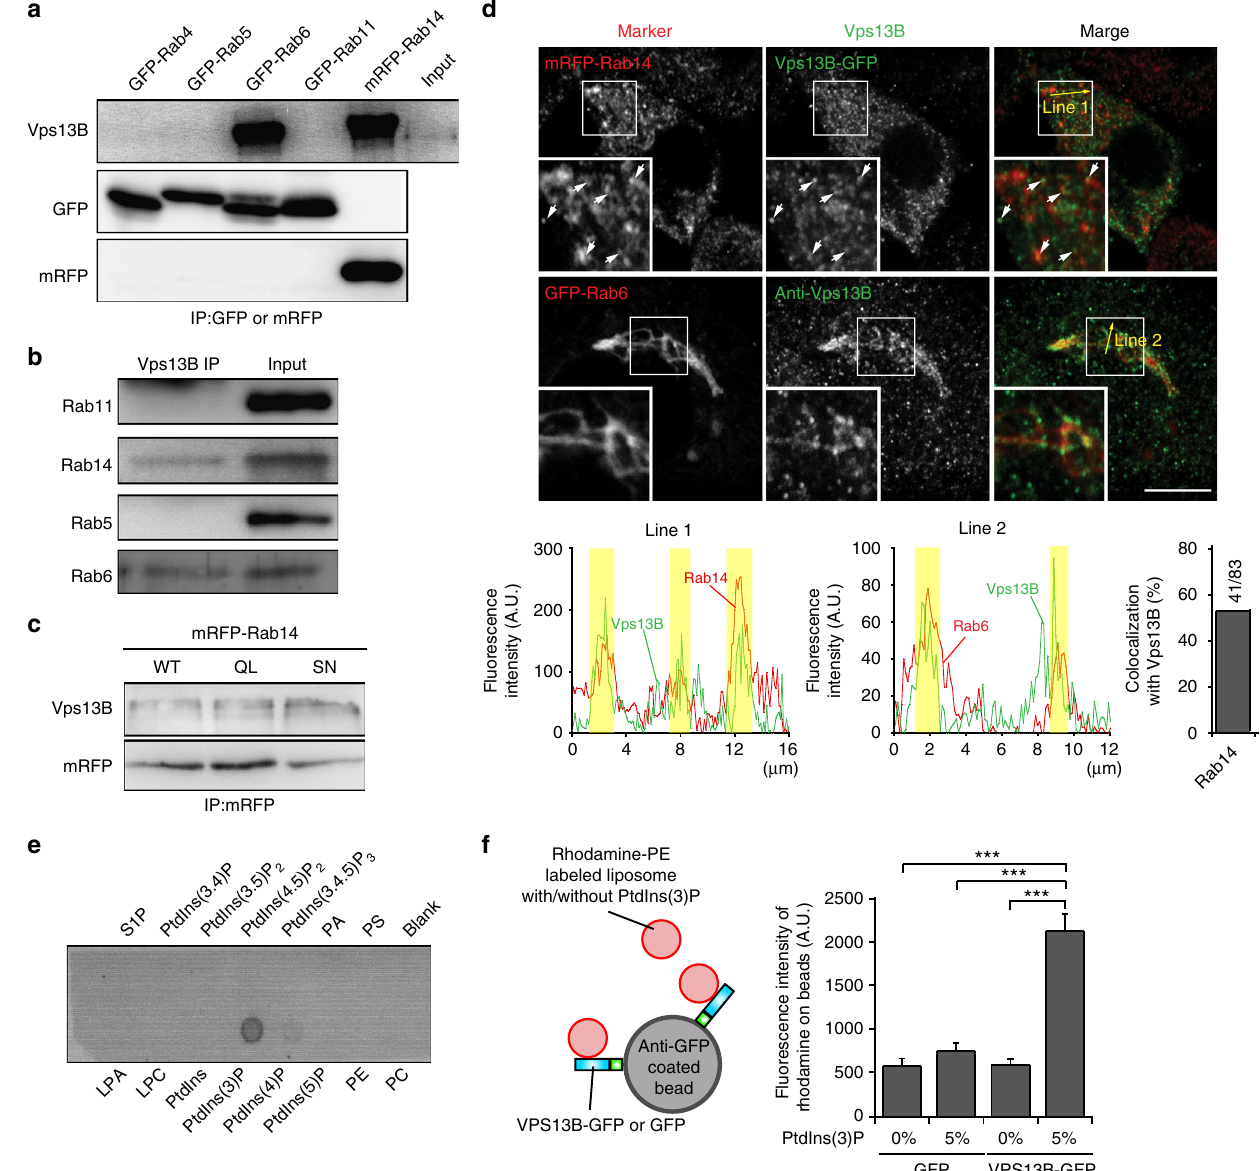
Fig. 6 Vps13B speci fi cally binds to Rab14 and Rab6 and to PtdIns(3)P. a , b Association of endosomal Rab proteins with Vps13B, revealed by co- immunoprecipitation of endogenous Vps13B with GFP (or mRFP)-tagged Rab proteins. a GFP (or mRFP)-tagged proteins were precipitated from cell lysates using a GFP-trap or anti-mRFP antibody. Bound proteins were analyzed by immunoblotting for Vps13B, GFP, and mRFP. b Cross-linked cells were lysed and immunoprecipitated with anti-Vps13B antibody. The interaction of Rab proteins was detected and indicated Rab protein antibodies. c Coimmunoprecipitation of VPS13B with mRFP-Rab14-WT, GTP-locked mRFP-Rab14Q70L (QL), or GDP-locked mRFP-Rab14S25N (SN) expressed in HeLa cells. Anti-RFP antibody was used for immunoprecipitation of mRFP-tagged Rab14 proteins. There was no signi fi cant difference in the binding of Vps13B to the Rab14 variants. d Vps13B co-localizes with Rab6 and Rab14 upon expression in HeLa cells. Top panel: cells were transfected with mRFP-Rab14 and Vps13B-GFP and analyzed for the presence of GFP and mRFP, respectively, by fl uorescence microscopy. Bottom panel: cells were transfected with GFP-Rab6. In this case, the distribution of endogenous Vps13B was monitored by immunocytochemistry. White arrows in the upper inserts show vesicles positive for both Vps13B and Rab14. Bottom panels show line scans on the lines in the upper panels and the percentage of colocalization of Rab14 with Vps13B. Scale bar, 10 µ m. e PIP strip-binding assay of Vps13B. Perinuclear supernatant from Vps13B-GFP overexpressing cells was incubated with a membrane strip containing the phosphoinositides as indicated and probed for bound Vps13B using an anti-GFP antibody. f Binding of Rhodamine-labeled liposomes to Vps13B-GFP that was immobilized on magnetic Dynabeads. After incubation, the beads were washed, and bound liposomes were detected by Rhodamine fl uorescence. Binding was only detectable when Vps13B-GFP was bound to the beads and when the liposomes contained 5% PtdIns(3)P. Error bars indicate S.E.M., *** P < 0.001, determined by unpaired t-